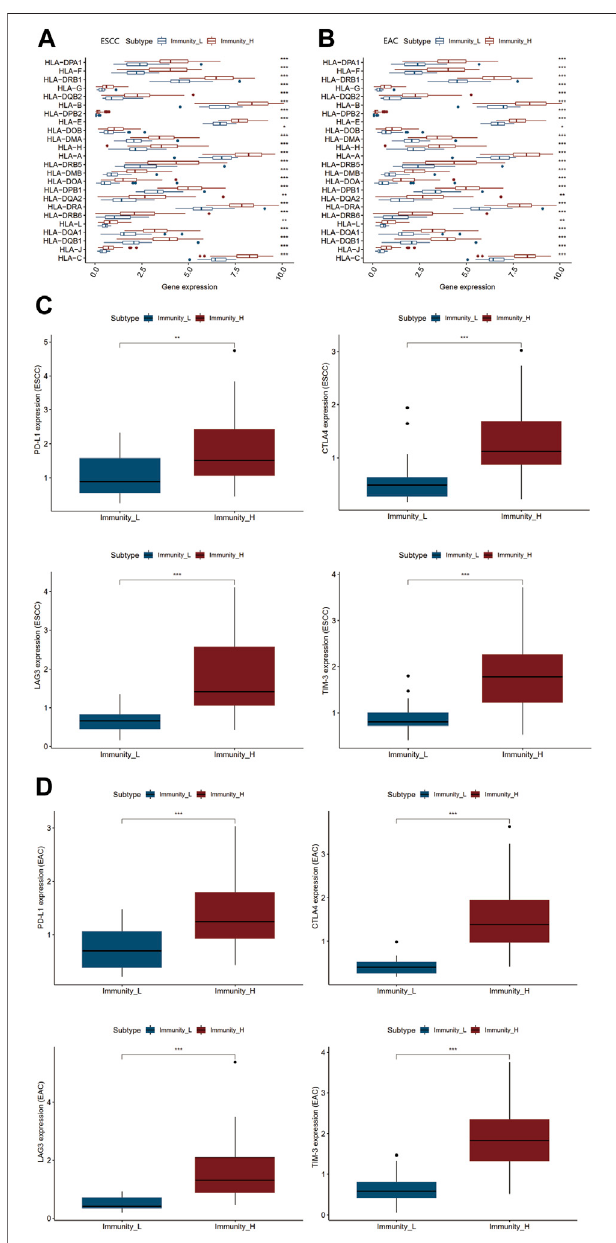
FIGURE 2 | Differential genetic analyses of two immunity clusters in ESCC and EAC. (A) Differential expression of HLA family genes in Immunity_L and Immunity_H groups of ESCC. (B) Differential expression of HLA family genes in Immunity_L and Immunity_H groups of EAC. (C) Differential expression of PD-L1, CTLA4, LAG3, and TIM-3 in Immunity_L and Immunity_H groups of ESCC. (D) Differential expression of PD-L1, CTLA4, LAG3, and TIM-3 in Immunity_L and Immunity_H groups of EAC. * p < 0.05; ** p < 0.01; *** p <